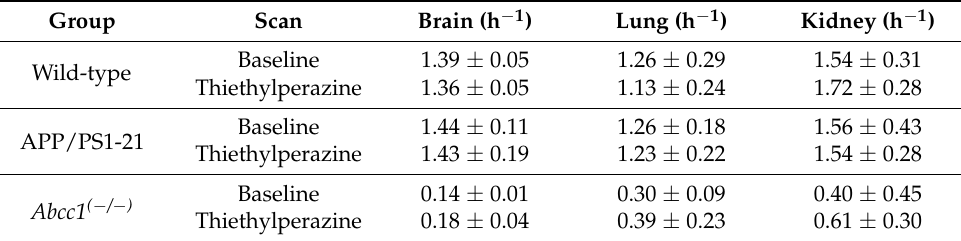
Table 2. Elimination rate constants ( k elim , h − 1 ) in the brain, the right lung and the left kidney of the three mouse strains before and after treatment with thiethylperazine.